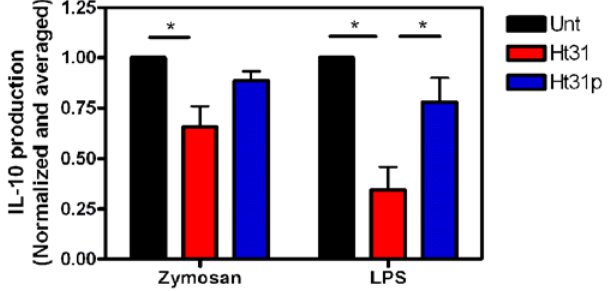
Figure 5. Ht31 inhibits secretion of IL-10. Day 5 DC were incubated with 30 m g/ml Zymosan or 10 ng/ml LPS, without (Unt, black bars) or with 100 m M Ht31 (red bars) or Ht31p (blue bars) for 24 hours at 37 u C, 5% CO 2 . Supernatants were collected and used in IL- 10 ELISA (R&D Systems). Three experiments were normalized and averaged. Error bars are S.E.M. Student TTEST reveals significance, P , 0.05(*) or P , 0.005(**).